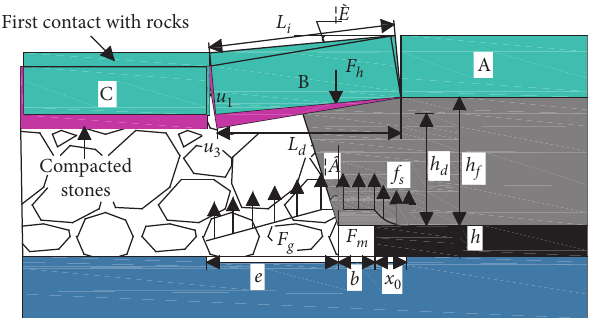
Figure 2: Mechanical structure model of key